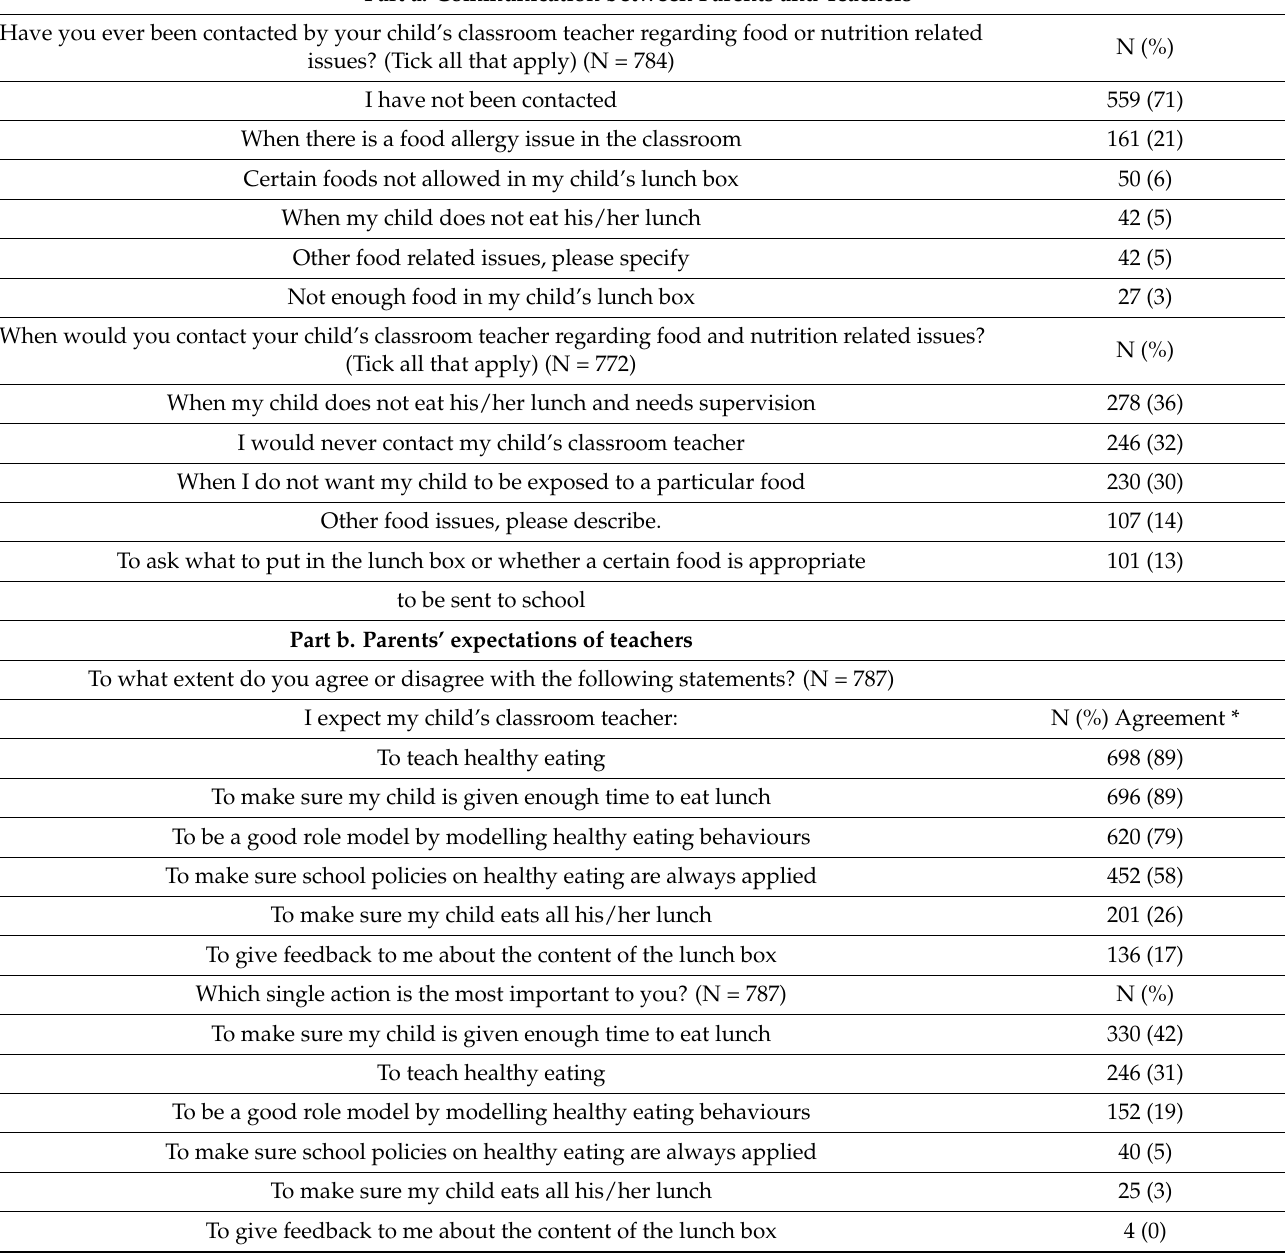
Table 3. Parents’ communication from and expectations of their child’s classroom teacher. Part a. Communication between Parents and